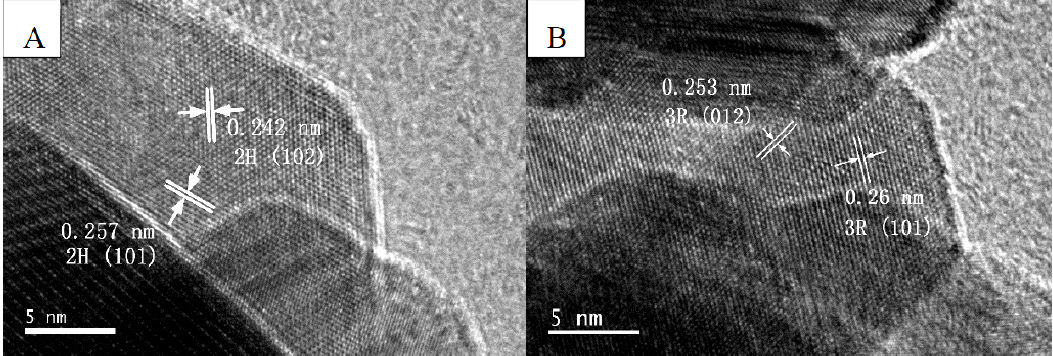
Figure 2. HRTEM image of 2H phase ( A ) and 3R phase ( B ) of AFO ‐ 6.